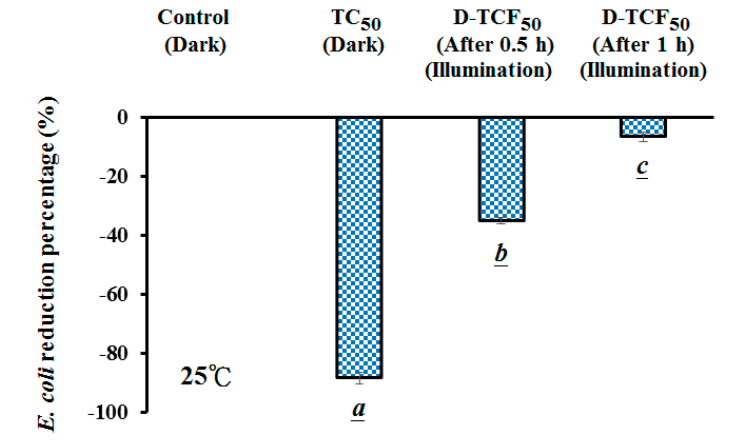
Figure 6. Effects of TC and D-TCF on E. coli viability at 25 ± 3 °C. Data are expressed as the mean ± SD, where n = 3. Statistically significant difference ( p < 0.05) between an experimental group and the control is indicated by a letter below the bar. Any two experimental groups that are significantly different between each other are labeled by different letters.